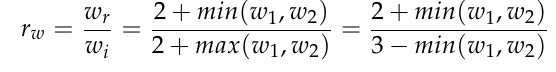
Figure 4. The initialization process of loss weights. From the accuracy curves of the activity recognition task and person identification task under several typical ratio values r w , it is shown that [ proper initial range for r w